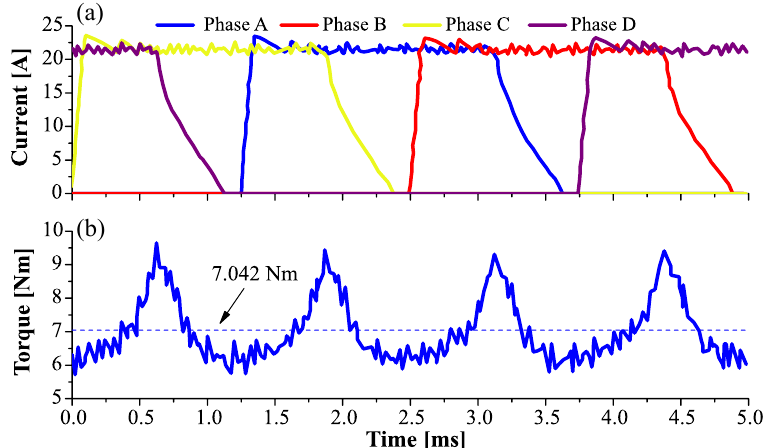
Figure 11. Dynamic results for the baseline 8/6 SRM at 2000 rpm: ( a ) phase currents and ( b ) electro- magnetic torque.